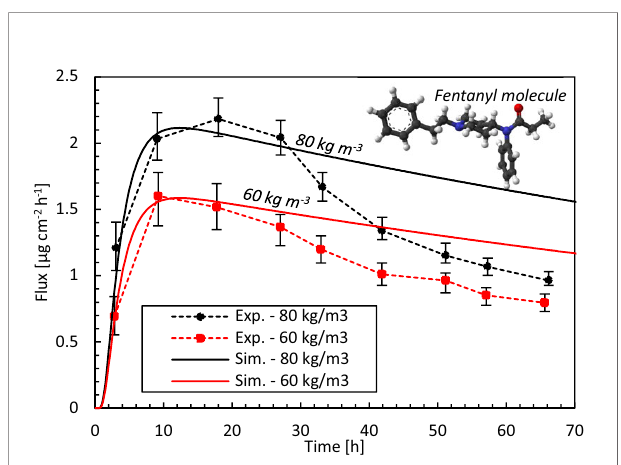
FIGURE 3 | Drug fl uxes of fentanyl at surface 1 ( g bl,up ), so leaving the epidermis, from experiments (Exp.) and simulations (Sim.) for two initial patch concentrations (60 kg m -3 , 80 kg m -3 ) as a function of time. The fentanyl molecule is illustrated as well, where the oxygen is depicted in red, carbon in black, hydrogen in white, and nitrogen in